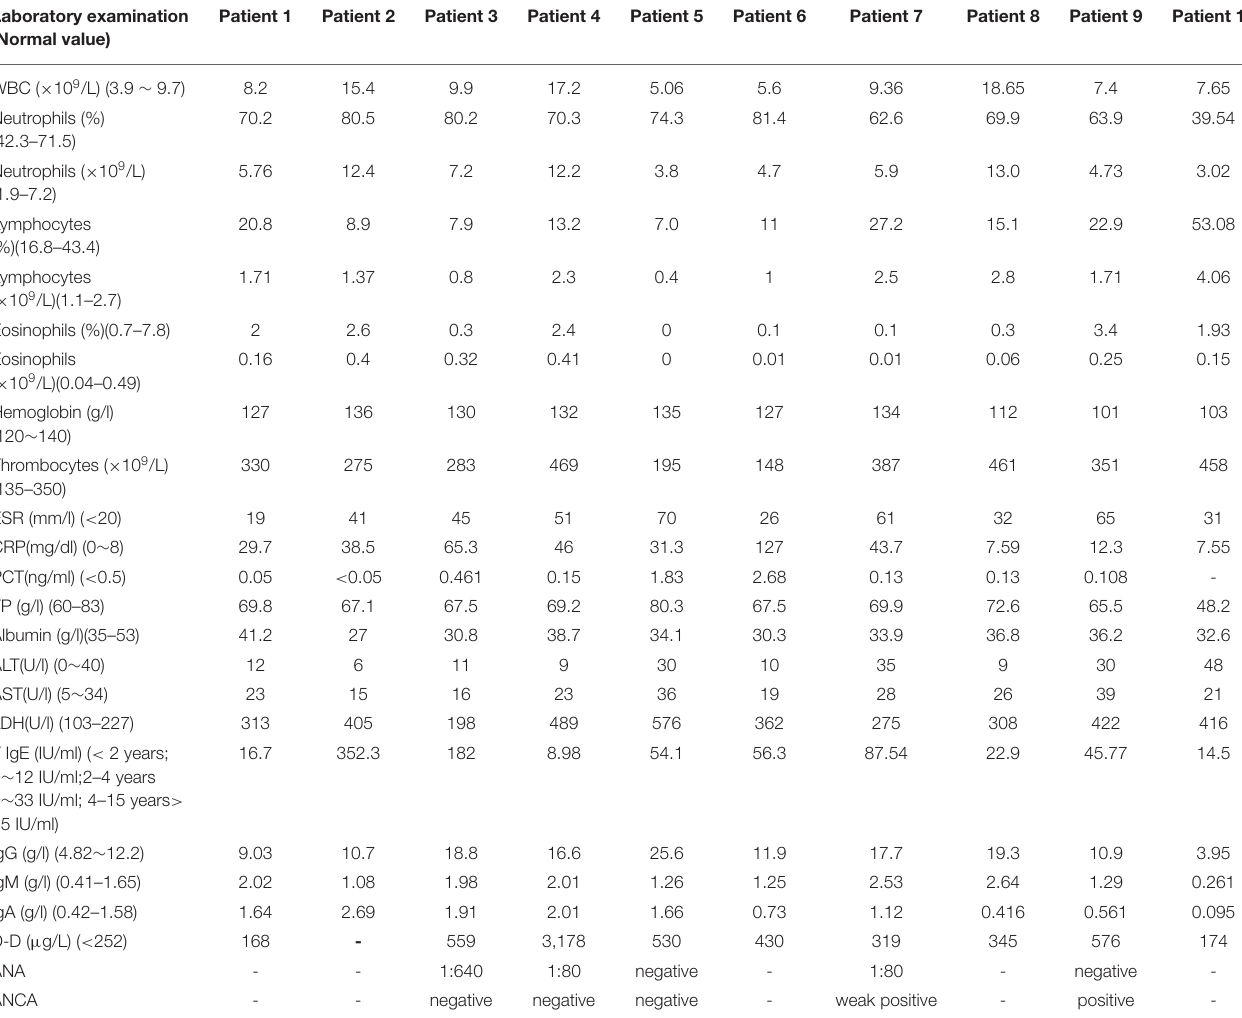
TABLE 2 | Laboratory test results of the 10 patients with